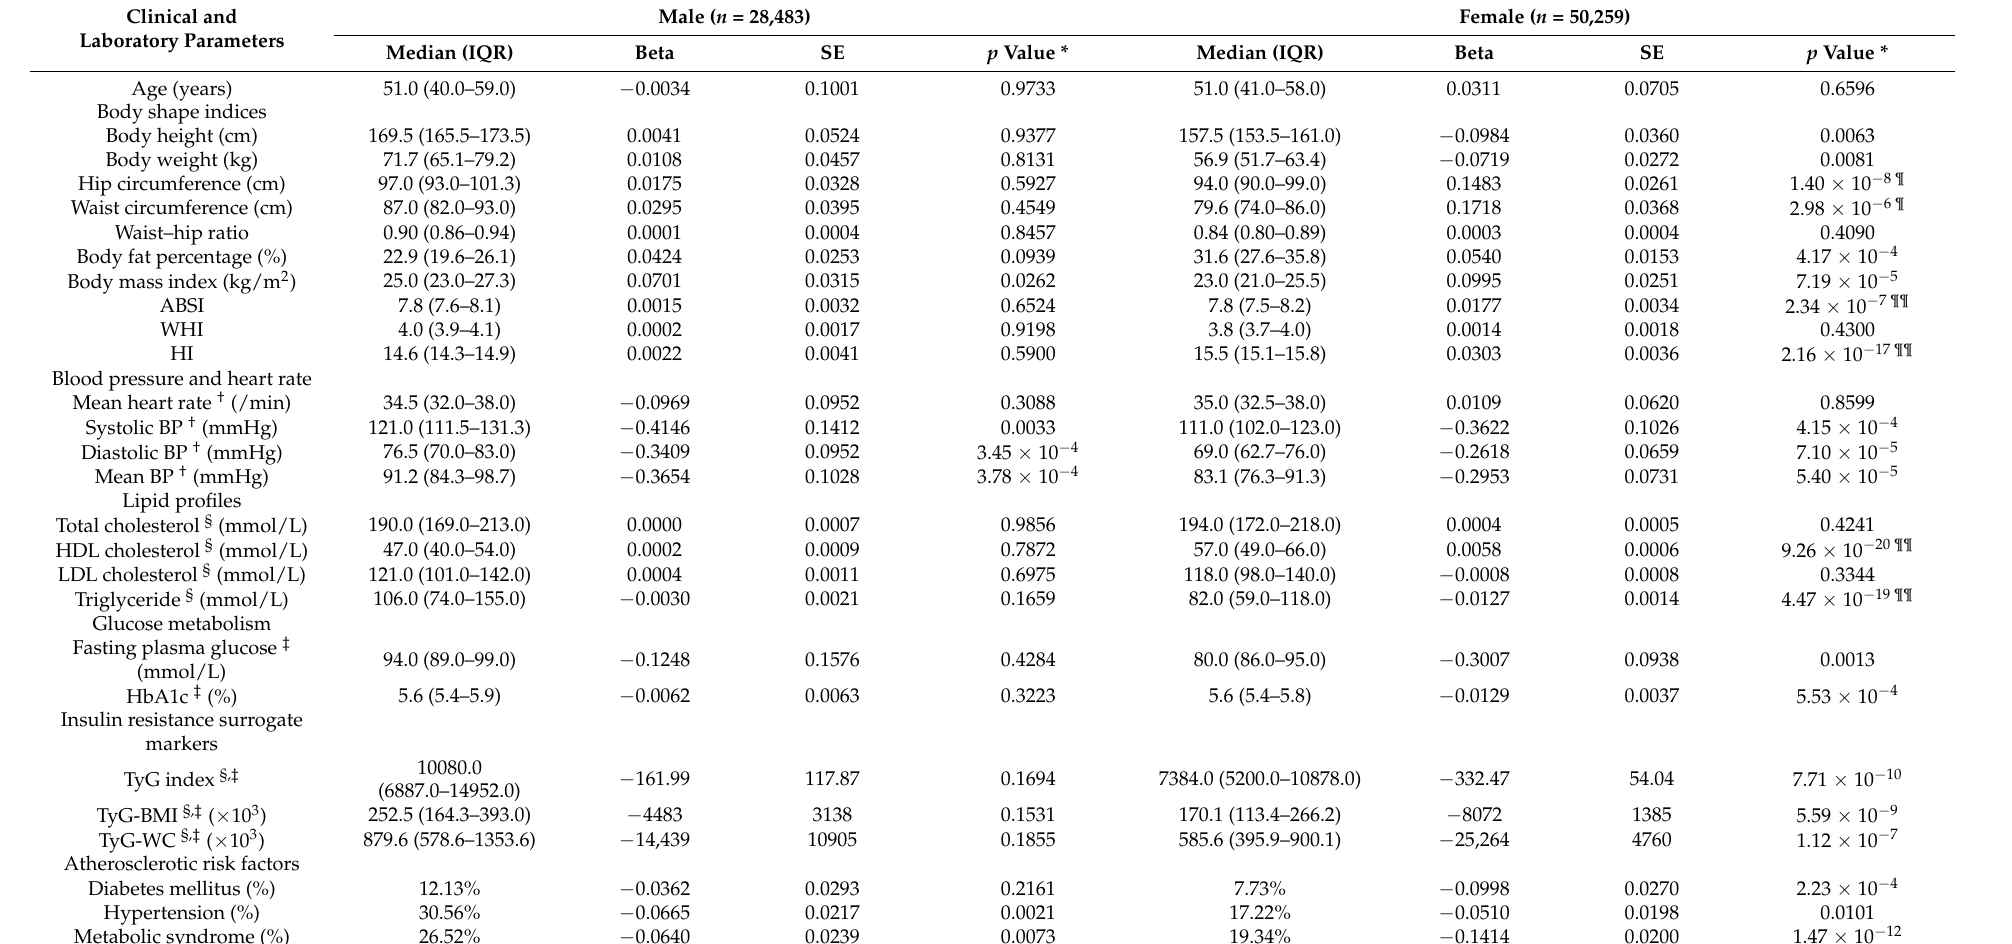
Table 2. Association between KLF14 rs4731702 genotype and body shape indices and metabolic traits according to